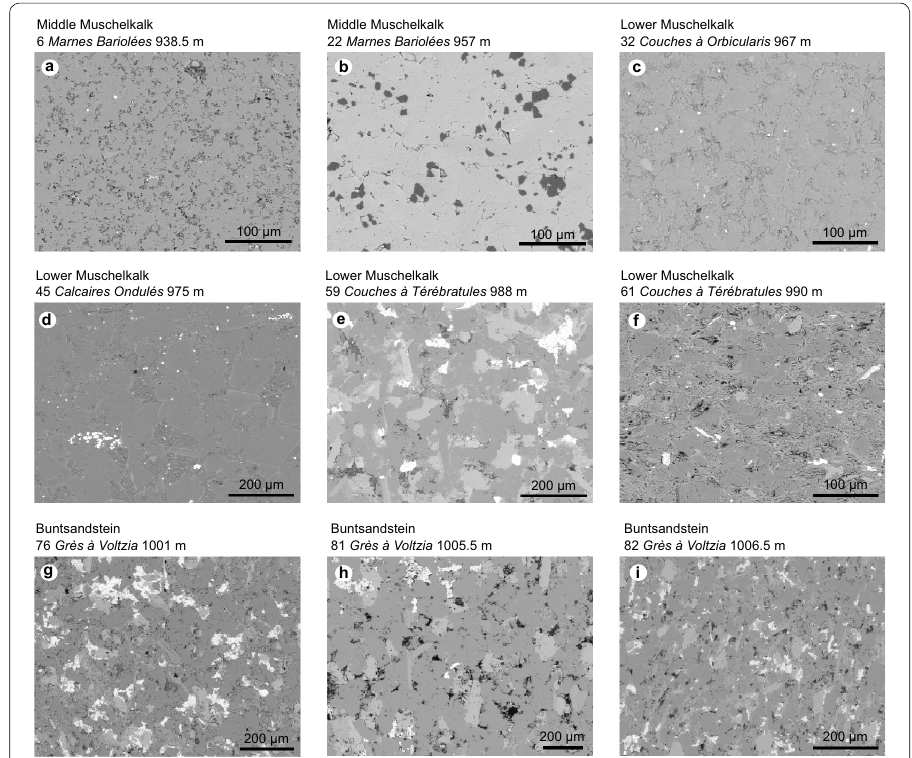
Fig. 5 Zoomed backscattered scanning electron microscope images showing the microstructure (the pore and grain size in particular) of the six Muschelkalk samples chosen to represent the variability of the Muschelkalk at exploration well EPS-1 (Soultz-sous-Forêts) ( a – f ), and three samples from the Buntsandstein at the Muschelkalk–Buntsandstein interface ( g – i ). The lithological unit, box number, and measured depth are given next to each